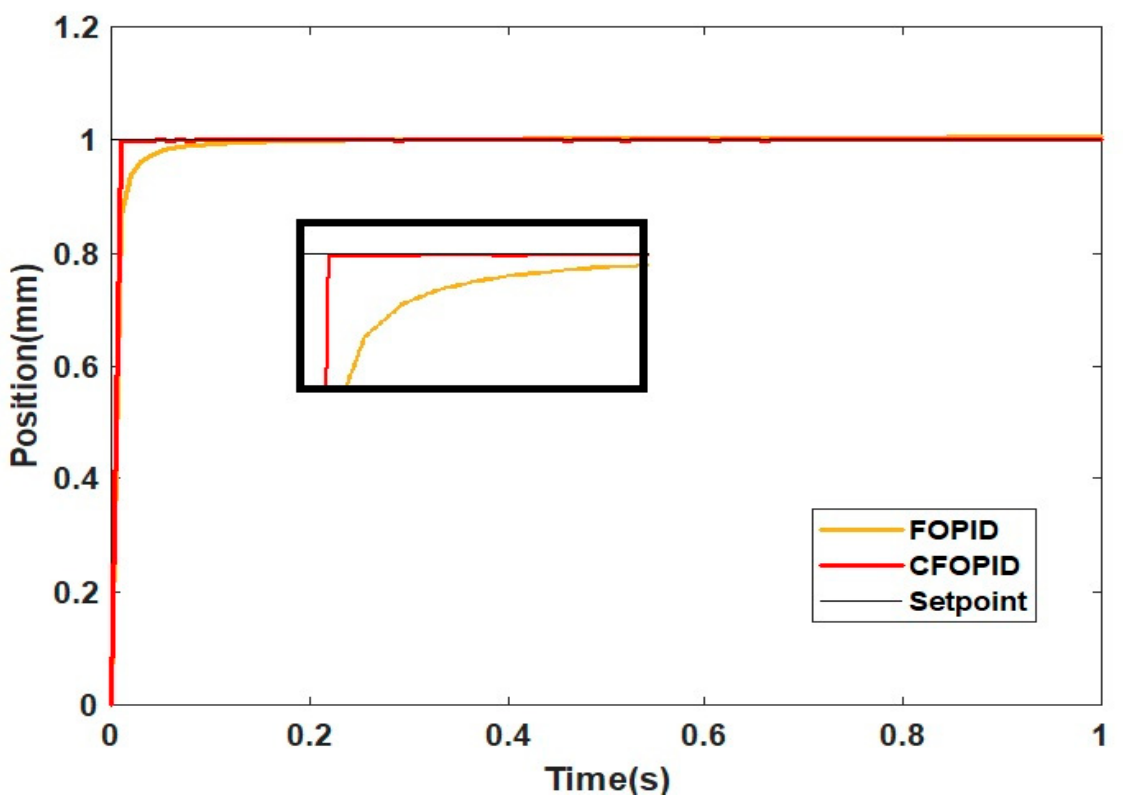
Figure 13. The responses of CFOPID and FOPID controllers.